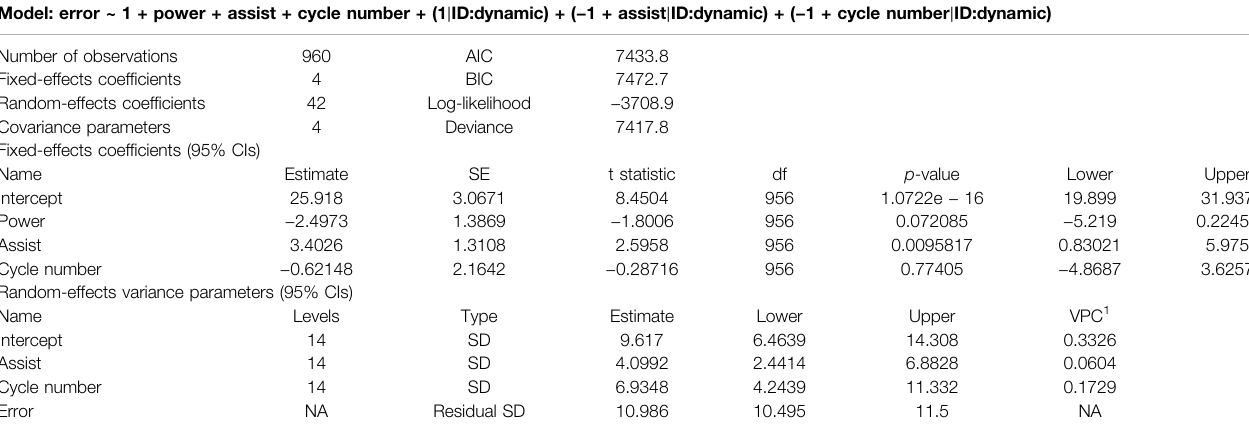
TABLE 3 | Mixed-effects model for user